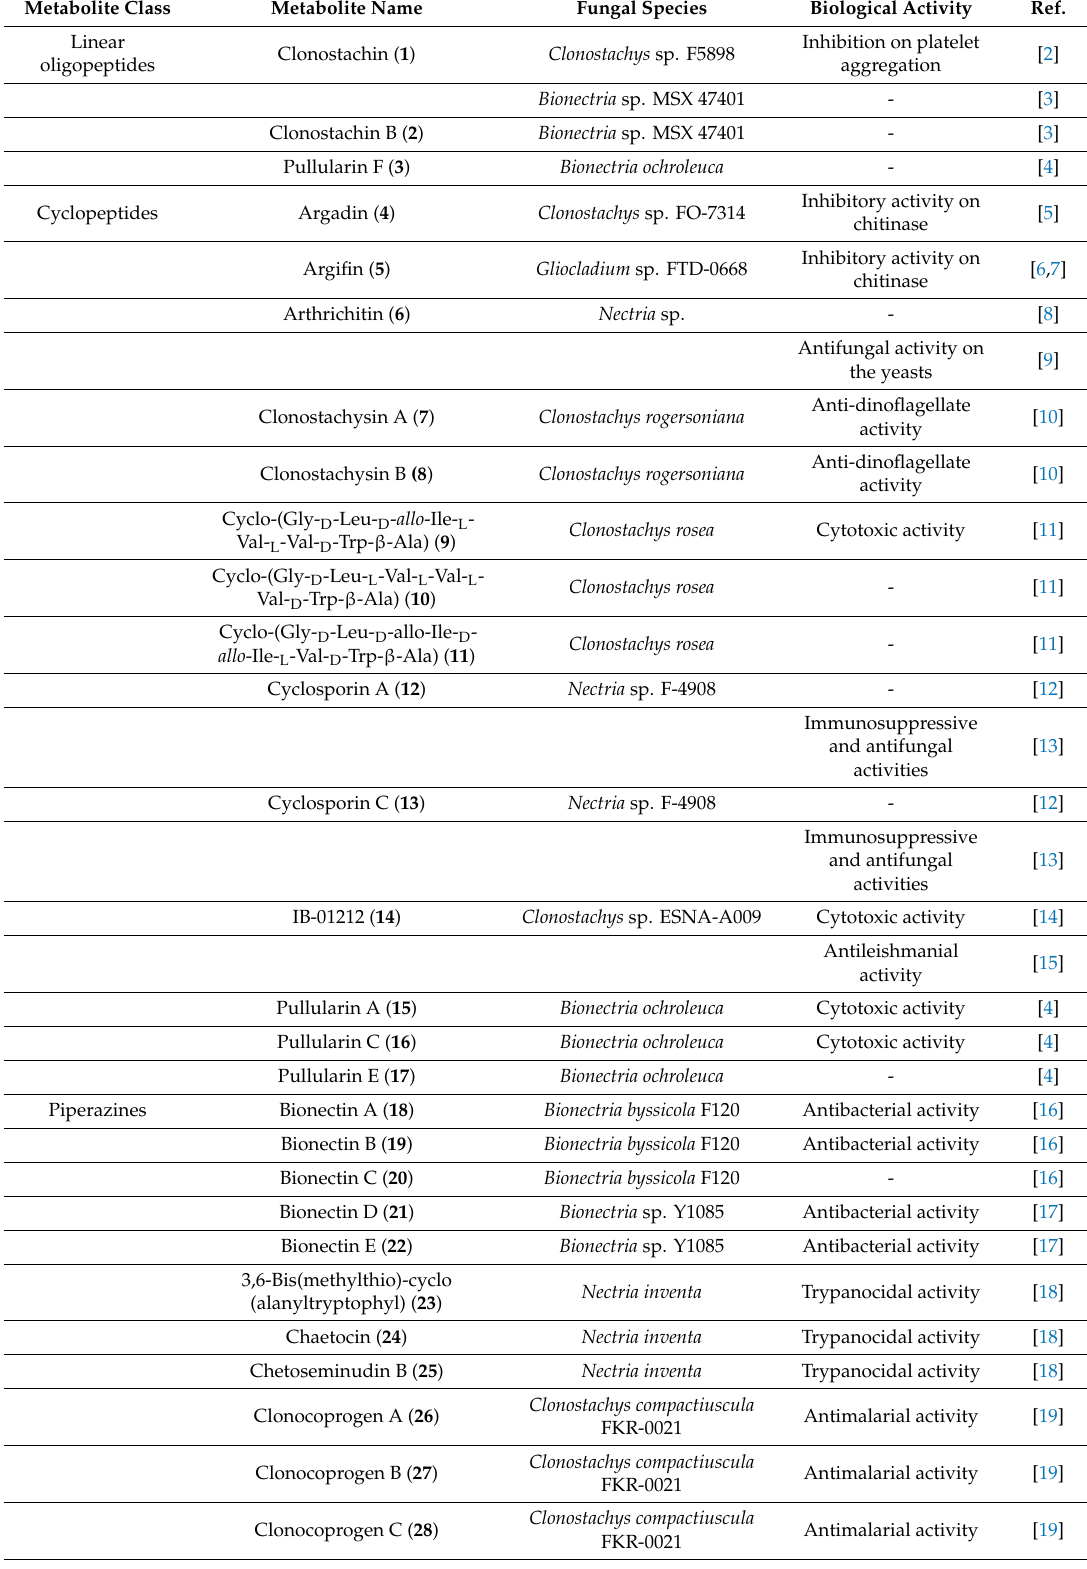
Table 1. Nitrogen-containing metabolites in Clonostachys fungi and their biological